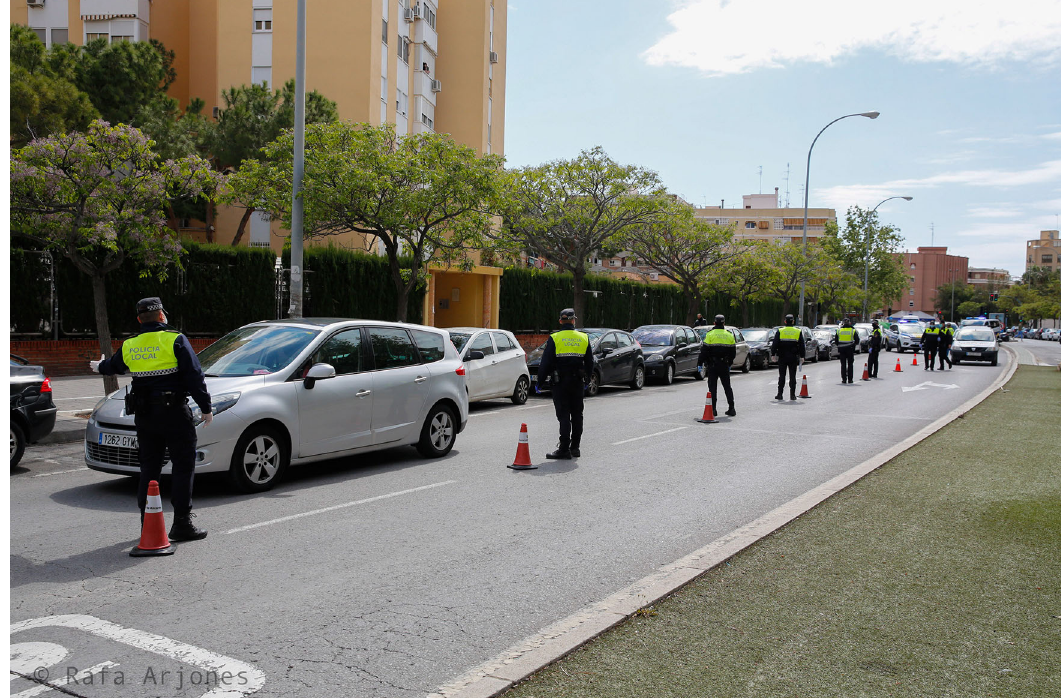
Figure 4. Eight municipal police officers inform the population of the control measures established by the health authorities. This figure has been reproduced with kind permission of the